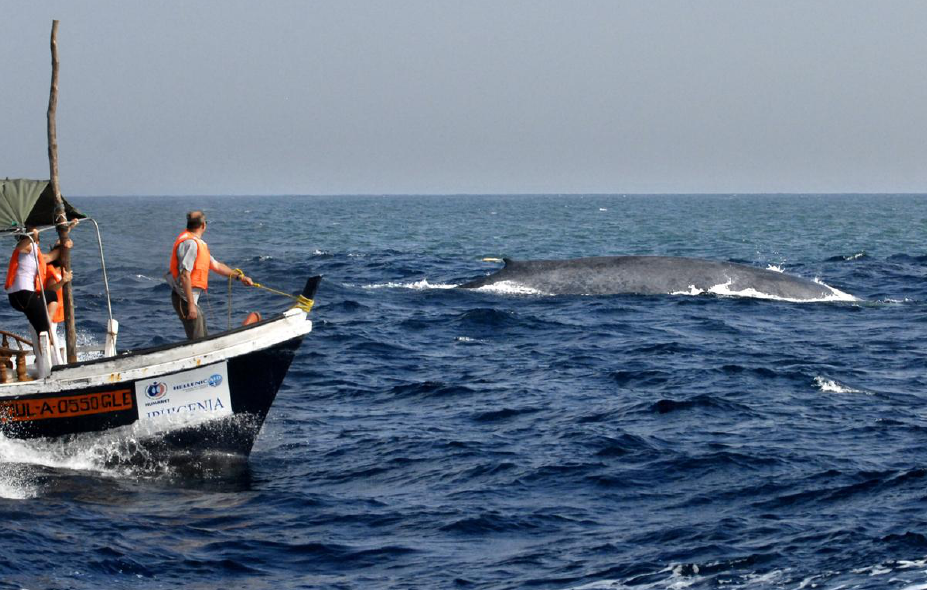
Figure 9. Image taken within study area showing distinct freshwater front between higher salinity dark blue water (foreground) and lower salinity greener water with higher turbidity